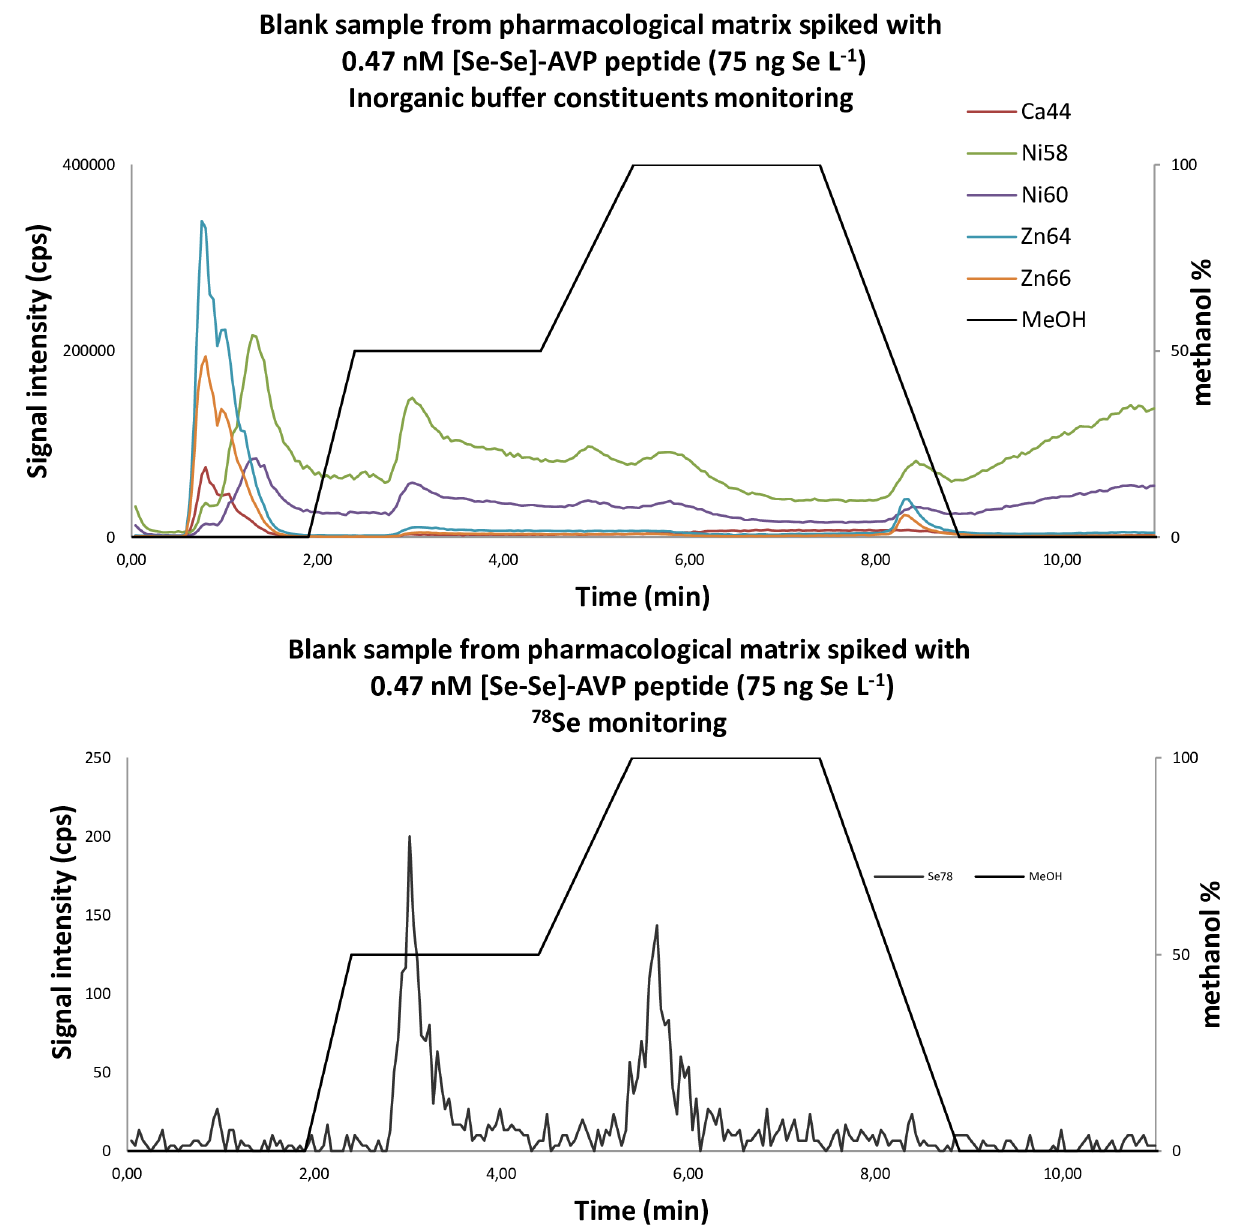
Fig 6. Overlaid RP-LC-ICP-MS chromatograms of a biological matrix spiked with